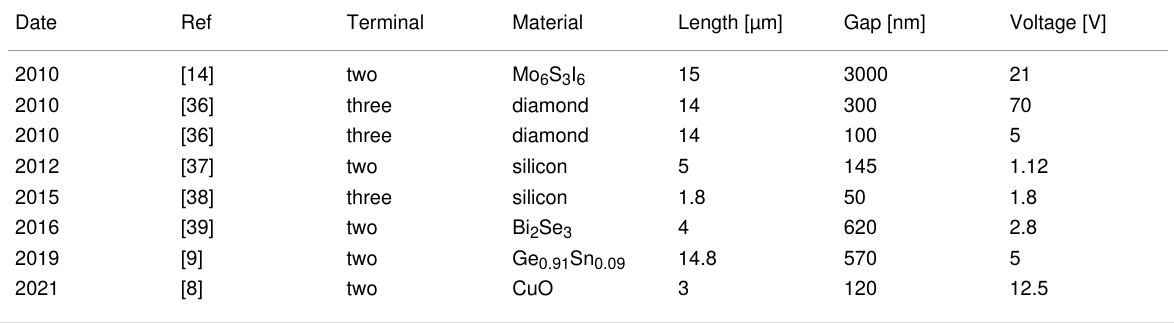
Table 3: Structure and pull-in voltage of nanowire switches.